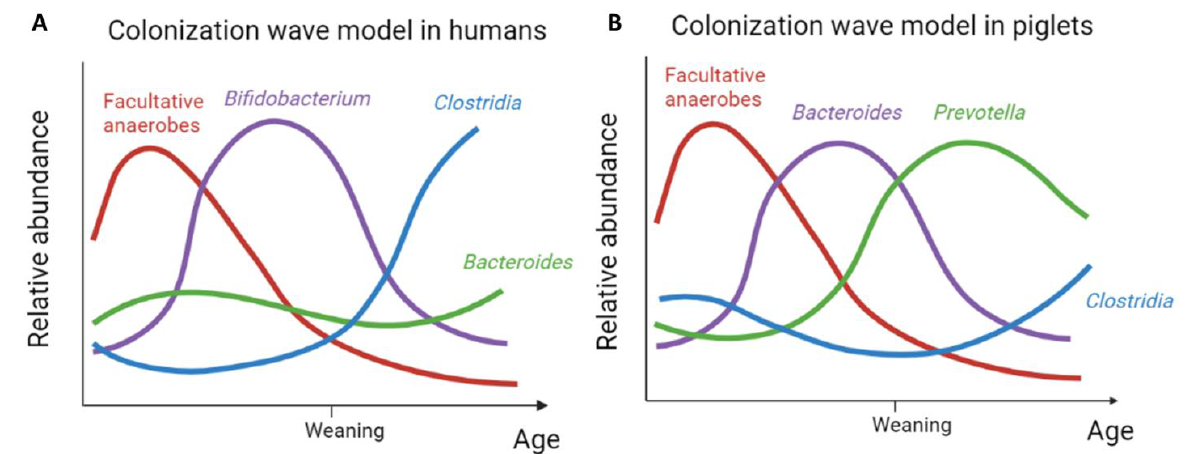
Figure 3. Model depicting the different bacterial colonization waves (not on scale) in humans ( A ) and pigs ( B ) over time. Our model in piglets was based on the colonization wave model in humans as proposed by Korpela and colleagues. Panel A: adapted with permission from Ref. [10] 2021, Korpela et. al.